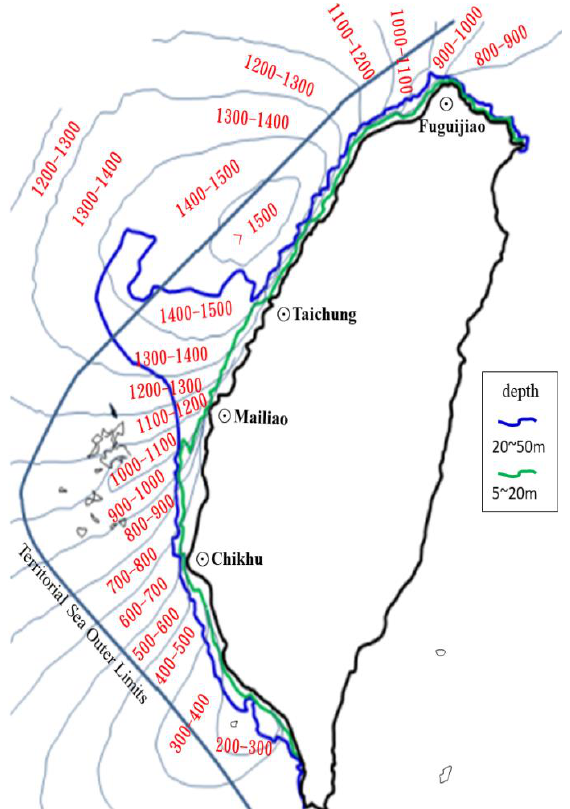
Figure 1. Distribution of the wind power density (W/m 2 ) in the ocean region close to Taiwan’s western coasts. Source: plotted by the authors based on the data in Reference [8].